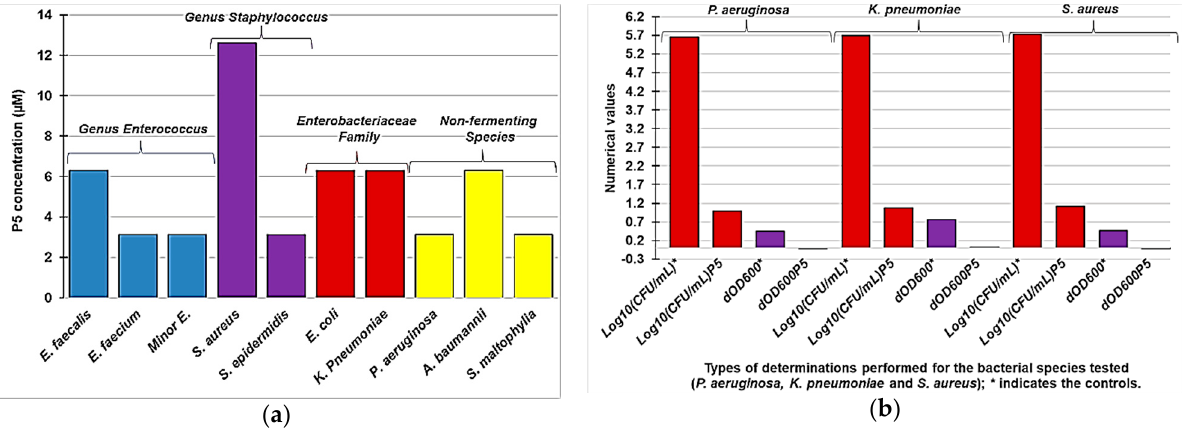
Figure 6. Best MIC values (µM) obtained on the main families of Gram-positive and Gram-negative bacteria reported in this study ( a ); comparison between the changes in the values of Log 10 (CFU/mL) (red bars) and OD 600 nm (purple bars) observed in the absence (*) and in the presence (P5) of the copolymer P5 ( b ).